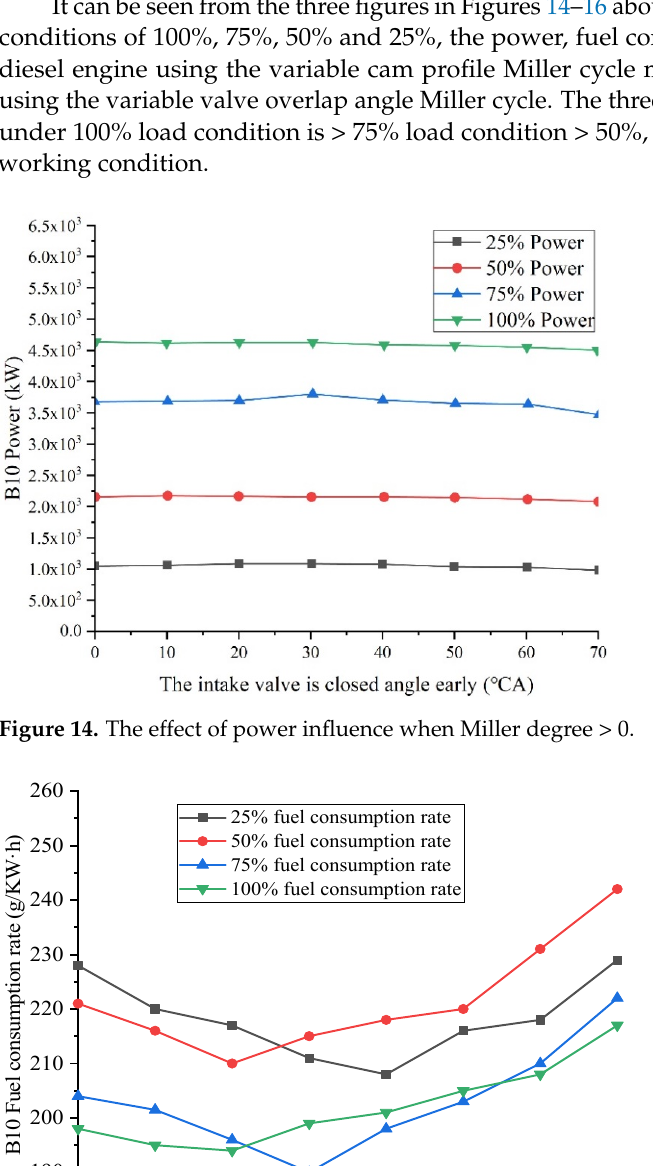
Figure 16. The effect of torque effect when Miller degree > 0.